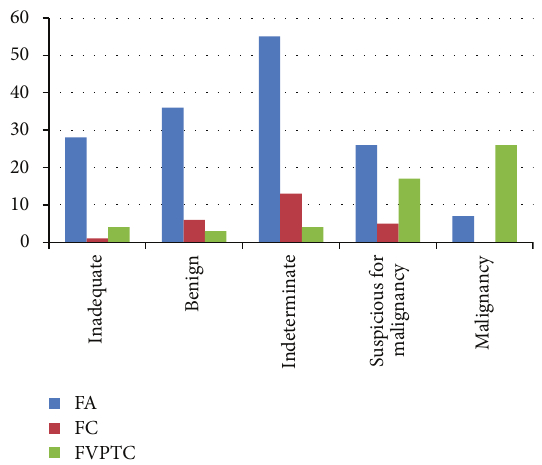
Figure 1: Results of USFNA cytology of the 231 thyroid nodules. Note: numbers in image represent percentages